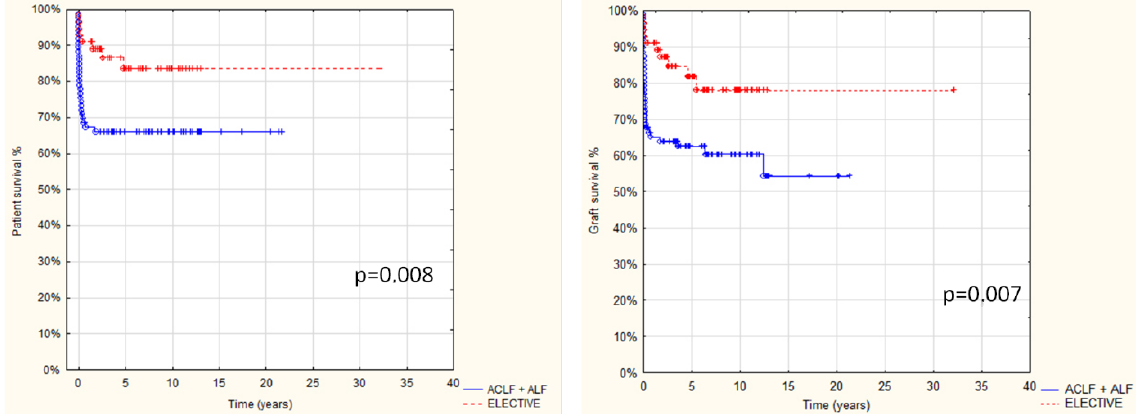
Figure 3. Comparison of patient and graft survival in relation to transplant urgency: elective vs. urgent (including acute-on-chronic and acute liver failure) in 142 pts after AB0i LT ( p < 0.05).